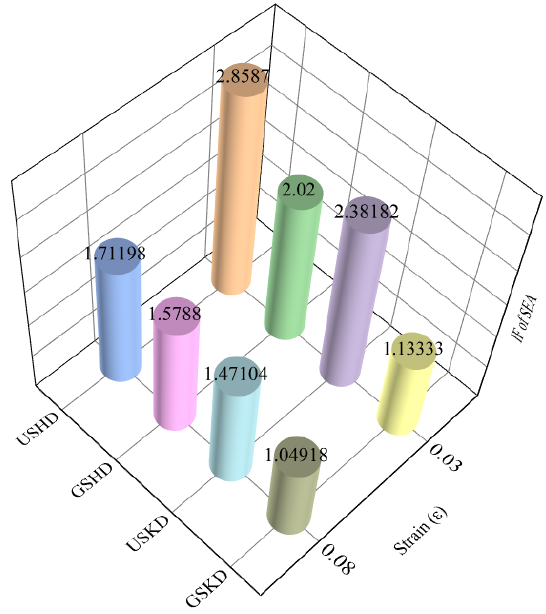
Figure 8. SEA after normalization of four structures.